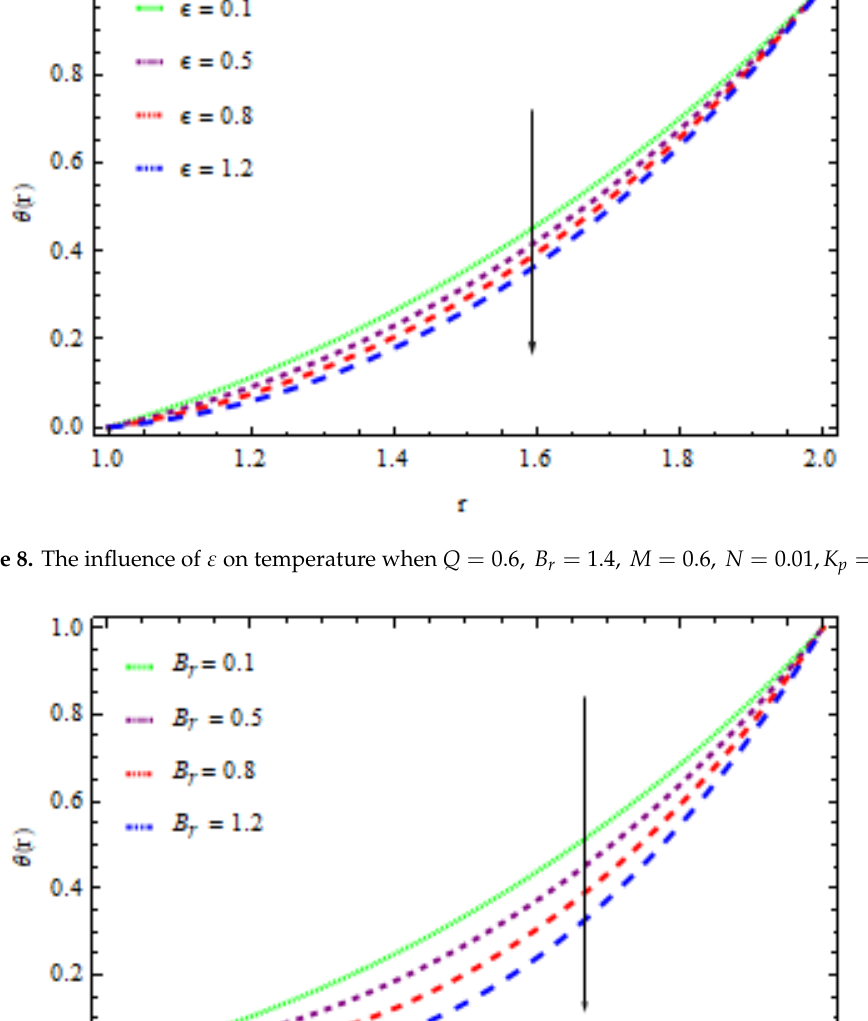
B on temperature when r